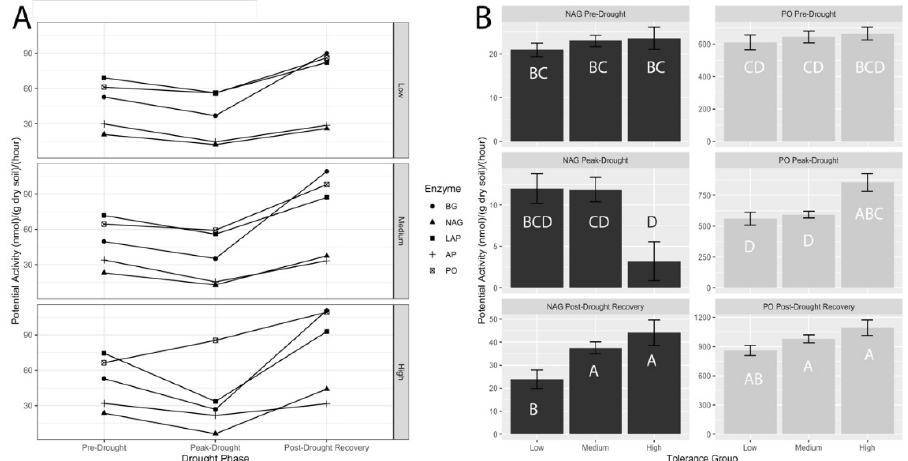
Figure 3. Potential Extracellular Enzyme Activities. The enzymes, N-acetyl glucosaminidase (chitinase) is indicated by NAG, leucine aminopeptidase is indicated by LAP, acid phosphatase is indicated by AP, and beta-glucosidase is indicated by BG. The enzyme activities were measured by fluorometric quantification, whereas phenol oxidase (indicated by PO) was quantified by absorption. AP and PO have been scaled to 1 / 10th activity in 3A to allow comparison of all enzymes together. ( A ) reports enzyme activity rates at the stages prior to drought, during drought, and after drought. In ( B ) the bar charts report the chitinase and phenol oxidase potential activities by drought tolerance level. Connecting letters indicate significance at alpha-level 0.05 and are specific to chitinase and phenol oxidase data. Error bars are standard errors of the mean.